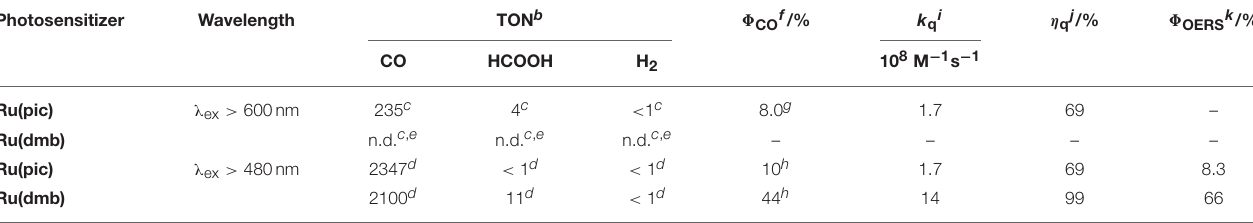
TABLE 3 | Photocatalytic properties using the mixed system of the Ru(II) photosensitizer and Re a . Photosensitizer